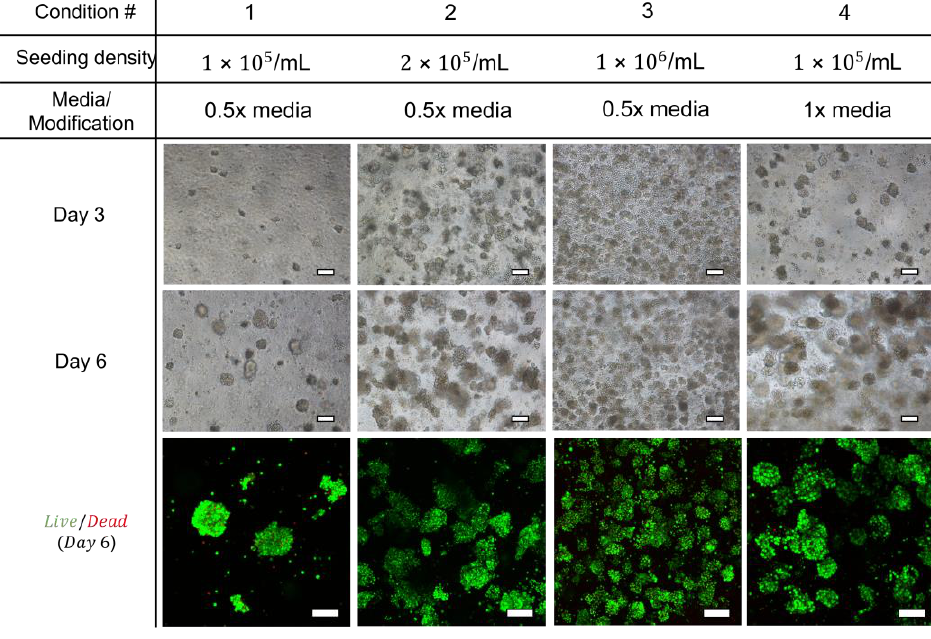
Figure 2. MLL-AF9 primary leukemia cells (mAF9) survive and form colonies in unmodified and modified self-assembling peptide hydrogels. Phase-contrast (top panel) and confocal images (bot- tom panel) of mAF9 cells in defined conditions of modified peptide hydrogels. Confocal images were taken 6 days following initial seeding and stained with Calcein AM and Ethidium Homodi- mer-1 to indicate viability. HA = Hyaluronan; scale bars = 100 µm. 2.3. Salinomycin, Vidofludimus, and Atorvastatin Show Efficacy in Liquid Culture Treatment of Human and Murine AML Cells. To initially evaluate the potential efficacy of the candidate drugs, a broad range of dosages of Salinomycin, Vidofludimus, and Atorvastatin were completed within liquid culture for the THP-1 human leukemic cell line (Figure 3A) and the mAF9 primary mouse